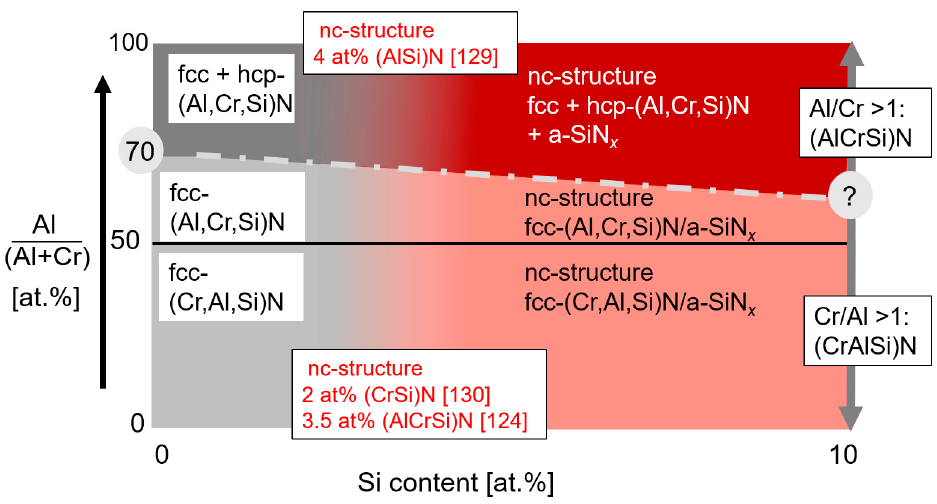
20 Figure 20. Schematic diagram of the phase evolution for (CrAlSi)N and (AlCrSi)N for different Al and Si contents in the coating, nc =